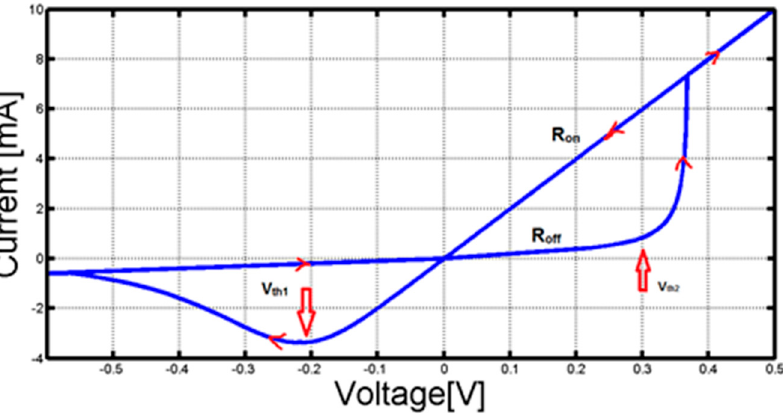
Figure 4. The I–V simulation curve of setup 3.